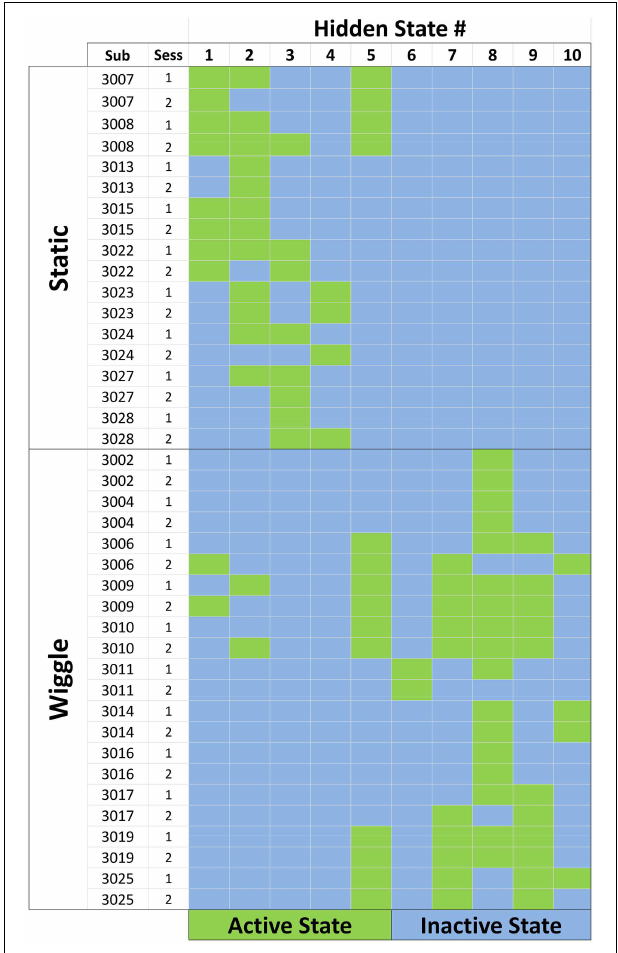
FIGURE 5 | Feature activation map for the ensemble of data sequences. Each row corresponds to a single session for a participant. Static participants had the wiggle tile-sorting function disabled during their interactions with the game. Columns correspond to the number assigned to each hidden state, and green cells indicate that the state in that column was active for the corresponding